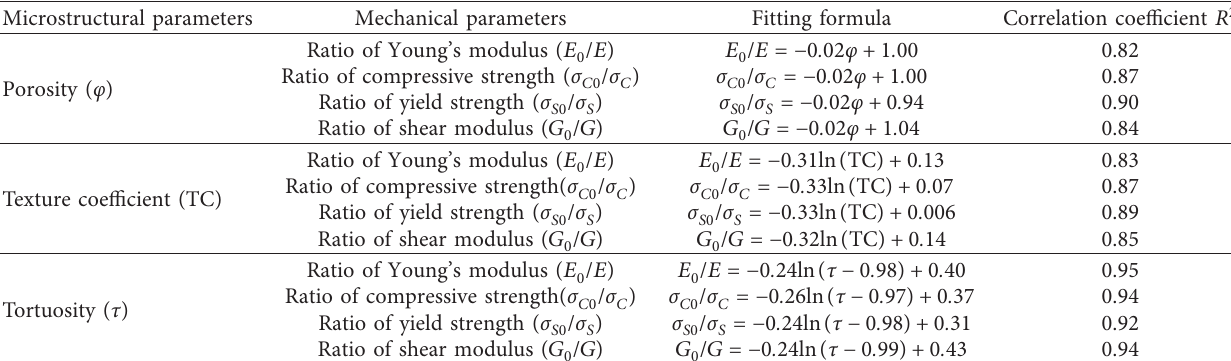
Figure 15: Correlation analysis between the tortuosity and the mechanical parameters of the digital core. (a) ∼ (d) are the ratio of Young’s modulus, ratio of compressive strength, ratio of yield strength, and ratio of shear modulus against the model tortuosity for correlation Table 6: Correlation between porosity, TC, tortuosity and mechanical parameters.